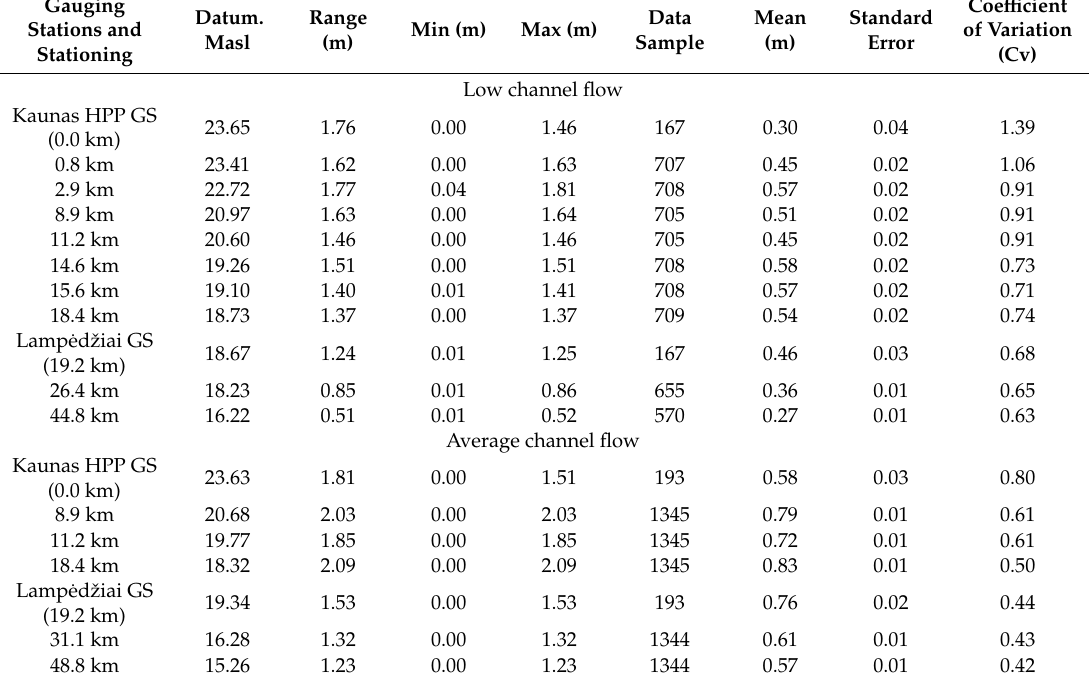
Table 1. Key statistics of gauged stage data series along Nemunas River during low and average channel flow.